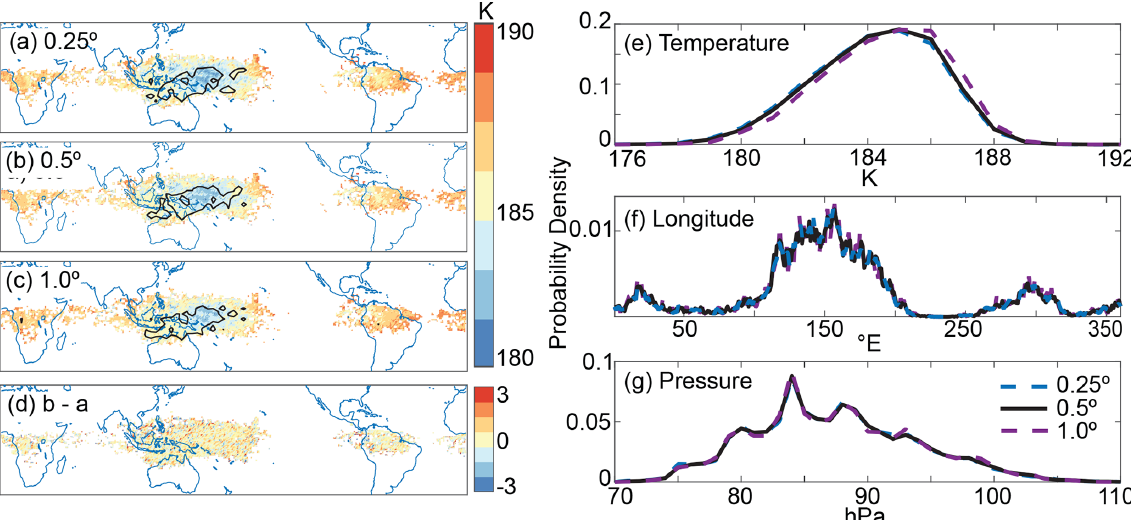
Figure 8. Panels (a–d) display spatial distribution of the DJF 2017 trajectories’ cold point temperature, and the difference in temperature between the 0.5 ◦ × 0.5 ◦ and 0.25 ◦ × 0.25 ◦ trajectories. Black contours in (a) , (b) , and (c) denote regions where the percent of trajectories crossing grid cells is greater than 0.03%. Panels (e–g) display probability density functions (PDFs) of the cold point temperature, longitude, and pressure for 0.25 ◦ × 0.25 ◦ , 0.5 ◦ × 0.5 ◦ , and 1.0 ◦ × 1.0 ◦ horizontal resolution